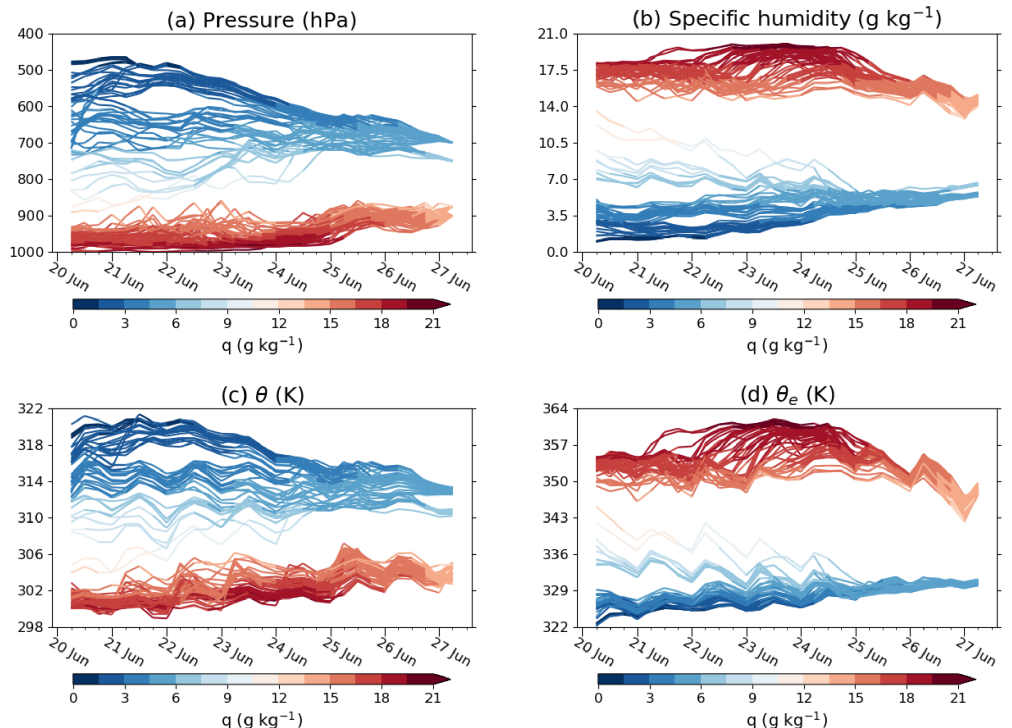
Figure 12. Time profiles of (a) pressure, (b) specific humidity, (c) potential temperature, and (d) equivalent potential temperature for the Mei Yu trajectories (see relevant map in Fig. 11c). Colour shading indicates specific humidity. Data from ERA5 1979–2018 climatology.